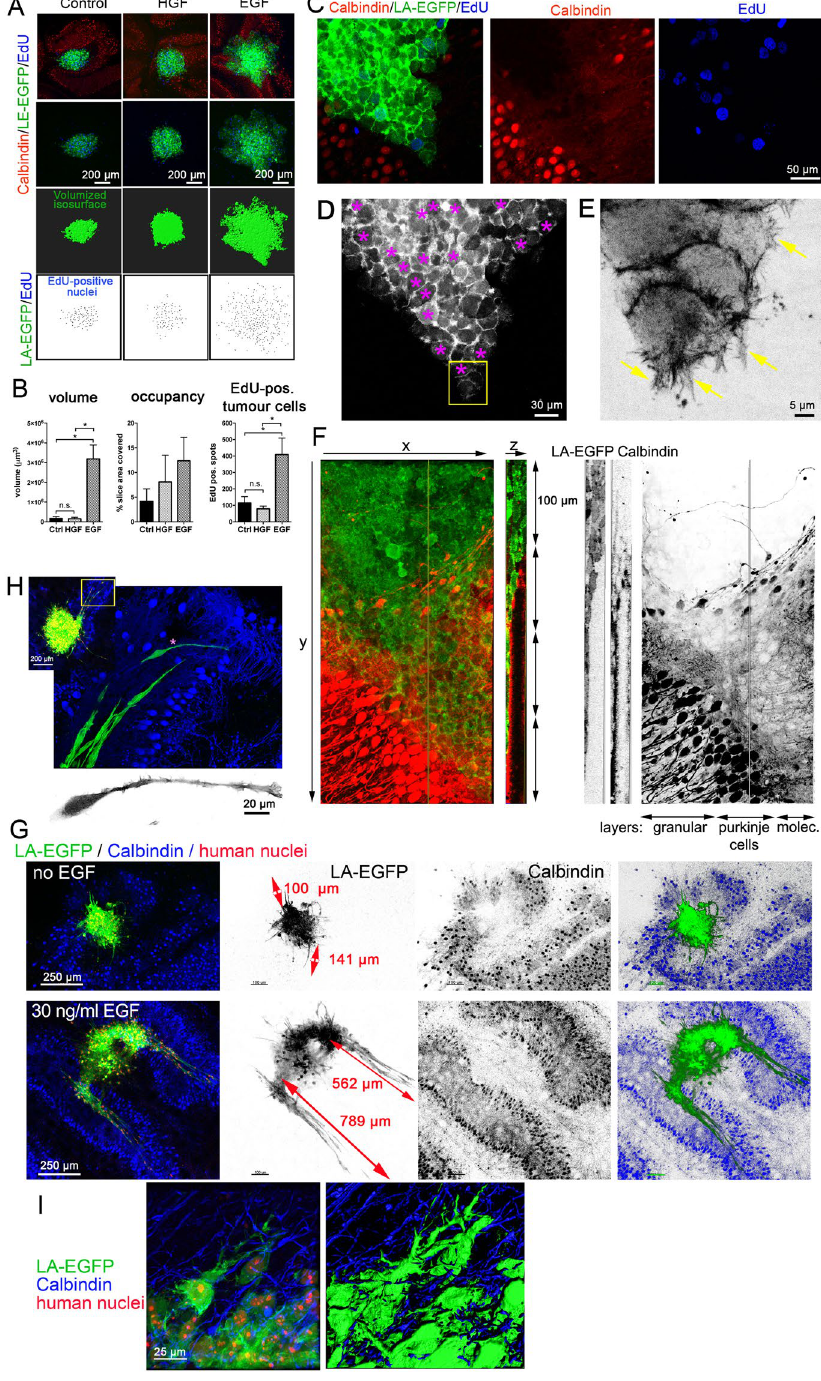
Figure 4. Quantification of relative growth and proliferation in response to HGF or EGF stimulation. (A) Confocal microscopy analysis of DAOY LA-EGFP cells spheroid co-cultured for five days in the OCSCs and exposed to the growth factors as indicated. EGFP signal was volumised and volume quantified. EdU-positive nuclei were marked and counted as well. ( B) Quantification of volume, occupancy (tumour area/slice area) and number of EdU-positive nuclei. Mean and SD of two independent experiments are shown. ANOVA statistical analysis was performed ( * = p < 0.05). ( C) Higher magnification of EGF-stimulated DAOY cells invading the molecular layer. D) Purple asterisks in LA-EGFP grey scale panel highlight the proliferating cells. E) Magnification of the invasion front (boxed inset in ( D ). Inverted grey scale image shows F-actin cytoskeleton of leading edge cells with distinct filopodia and lamellipodia (arrows). ( F) EGF-induced invasion of DAOY cells into molecular layer (green: LA-EGFP, red: anti-Calbindin). Orthogonal XYZ section shows infiltration of tumour cells into Purkinje cell layer. Red and green channels are also shown as inverted grey scale images for better visualization of the different layers. ( G) Comparison of growth and invasion of untreated and